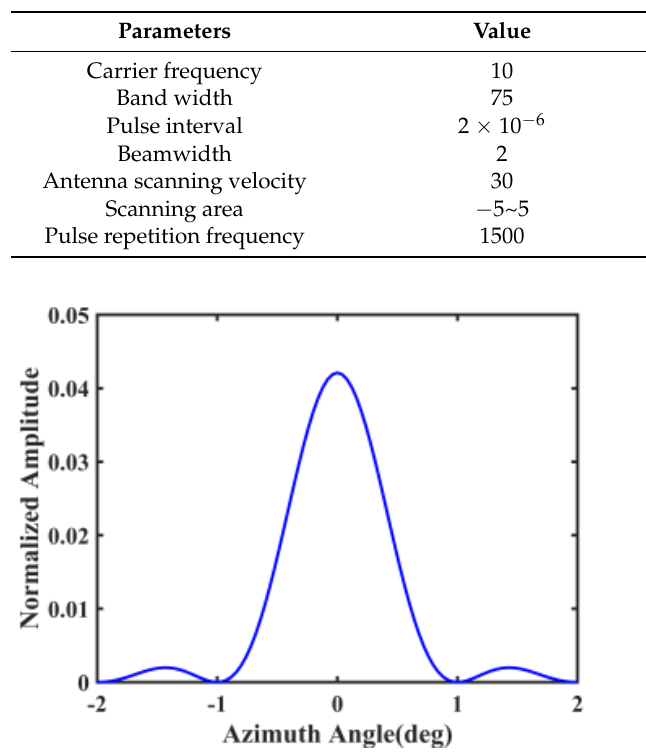
Figure 5. Simulated convolution kernel with sinc 2 function.